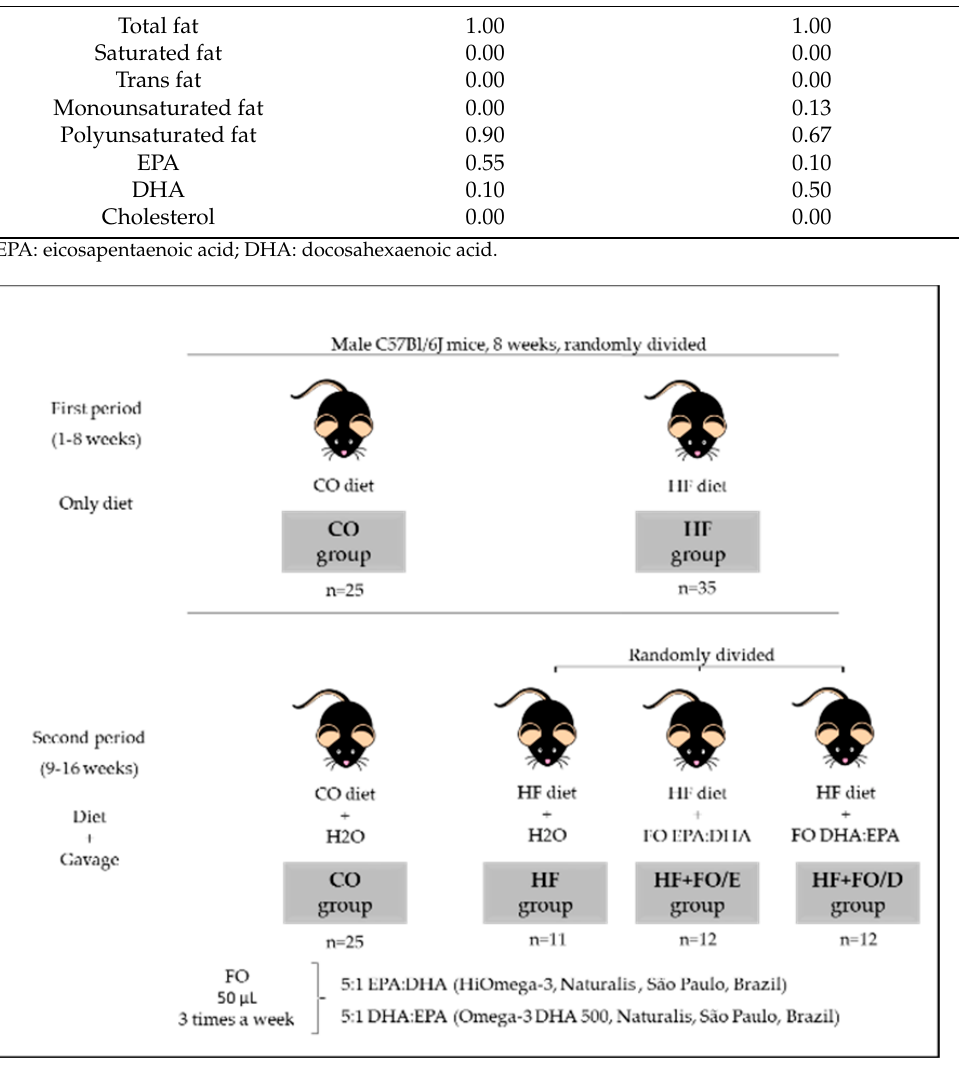
Figure 1. Experimental procedure. In the first period, the animals were randomly divided between CO or HF groups, which would receive the respective diets (CO: control diet and HF: high fat diet). In the second period, the CO group began to receive water by gavage, and the HF group was randomly divided into 3 groups: HF, which received water, HF+FO/E, which received FO (fish oil) containing a high concentration of EPA (eicosapentaenoic acid), and HF+FO/D receiving FO con- taining a high concentration of DHA. The gavage was performed 3 times a week, in a volume of 50 μ L.